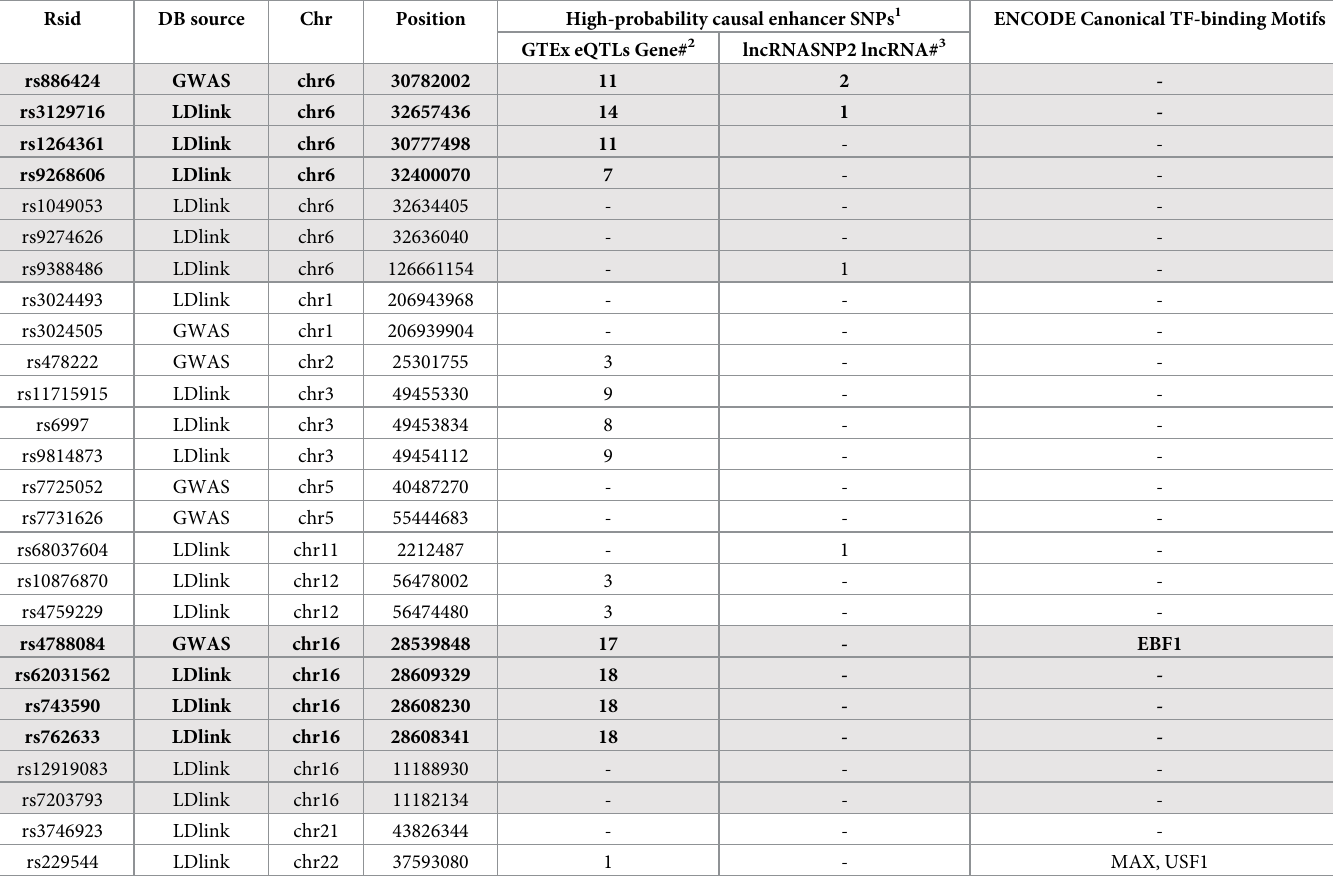
Table 1. High-probability causal enhancer SNPs, eQTLs, and lncRNAs.